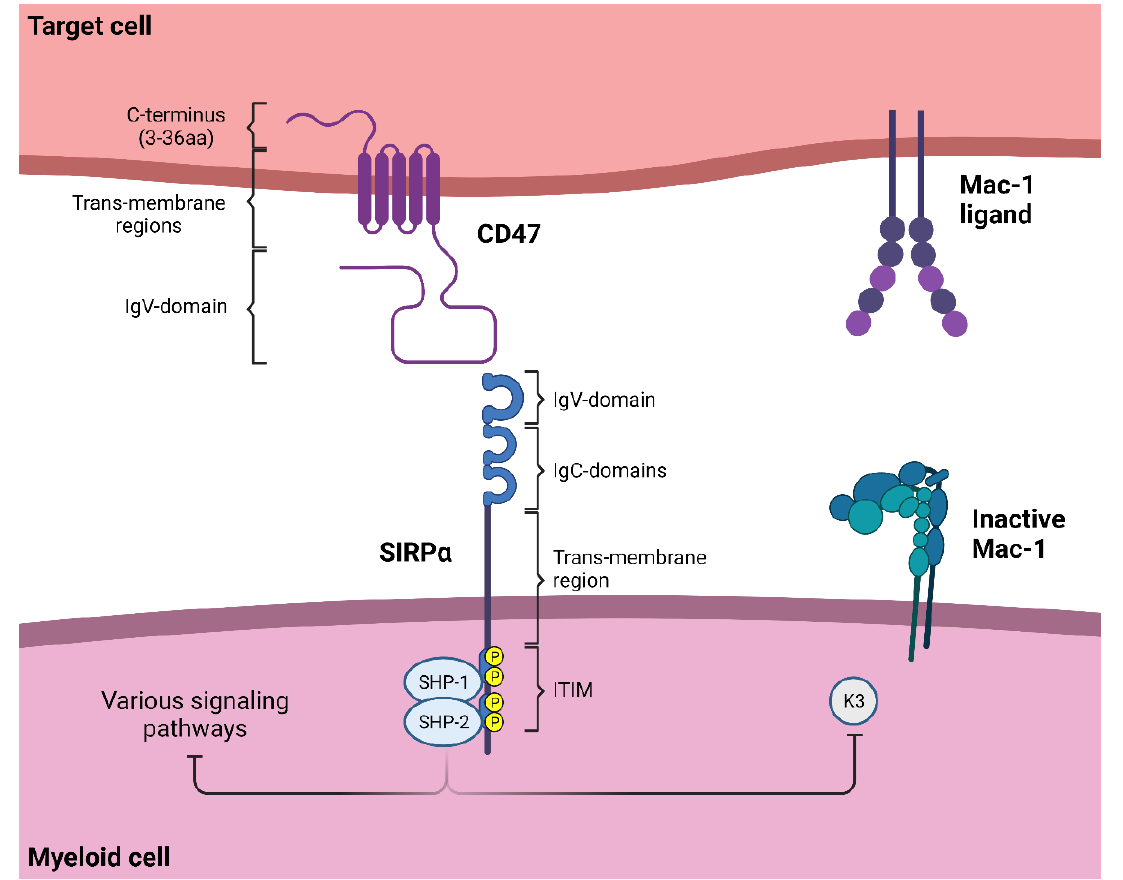
Figure 2. The CD47-SIRP α axis. Interaction between the IgV-domain of CD47 and the IgV-domain of SIRPα results in phosphorylation of the two ITIMs in the intracellular SIRPα tail. As a consequence, the phosphatases SHP-1 and SHP-2 are recruited, which are subsequently activated and able to regulate downstream cellular signaling pathways, e.g., FcR or TLR signaling, by tyrosine dephosphorylation of various mediators. In addition, neutrophil Mac-1 activation is inhibited in a Kindlin3-dependent manner. Abbreviations: K3: Kindlin3.